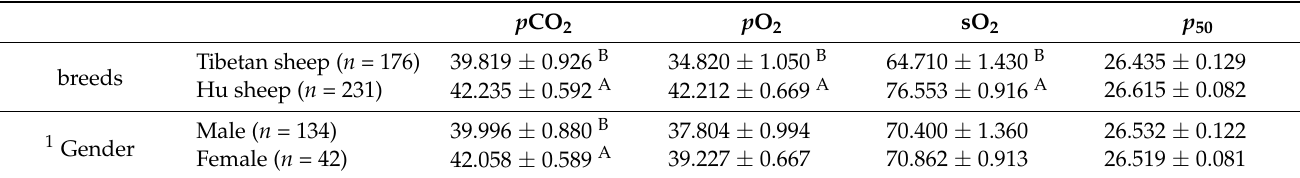
Table 4. The effect of breed and gender on blood gas.